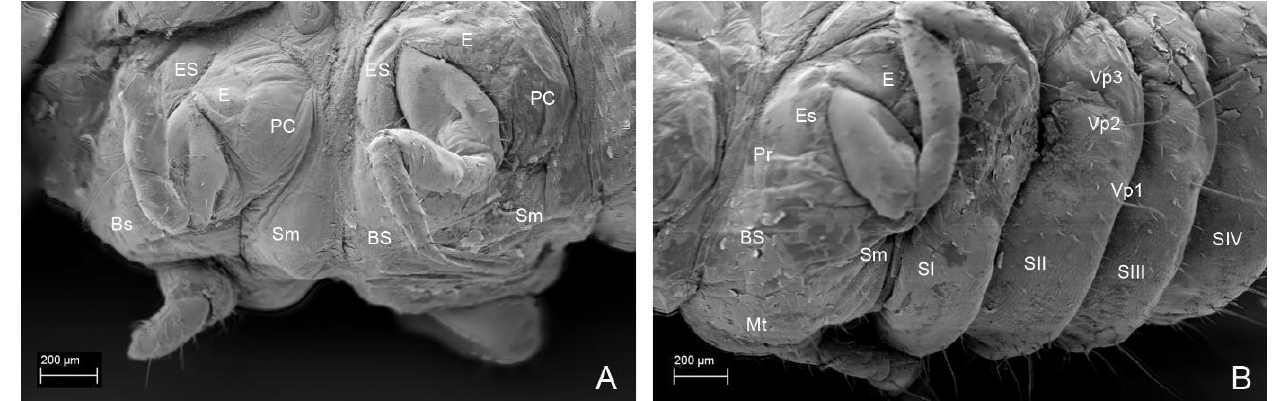
Figure 17. Leiodes cinnamomea. Details of larval morphology of instar III. Thorax in ventral view. ( A ) Pronota and mesonota. ( B ) Metanota and abdominal sternites I–III. Abbreviations: BS—basisternum; E—epimeron; ES—episternum; PC—postcoxale; Prc—precoxale; Pt—prothorax; SI– terminology of setae. Scale bars = 0.1 mm.